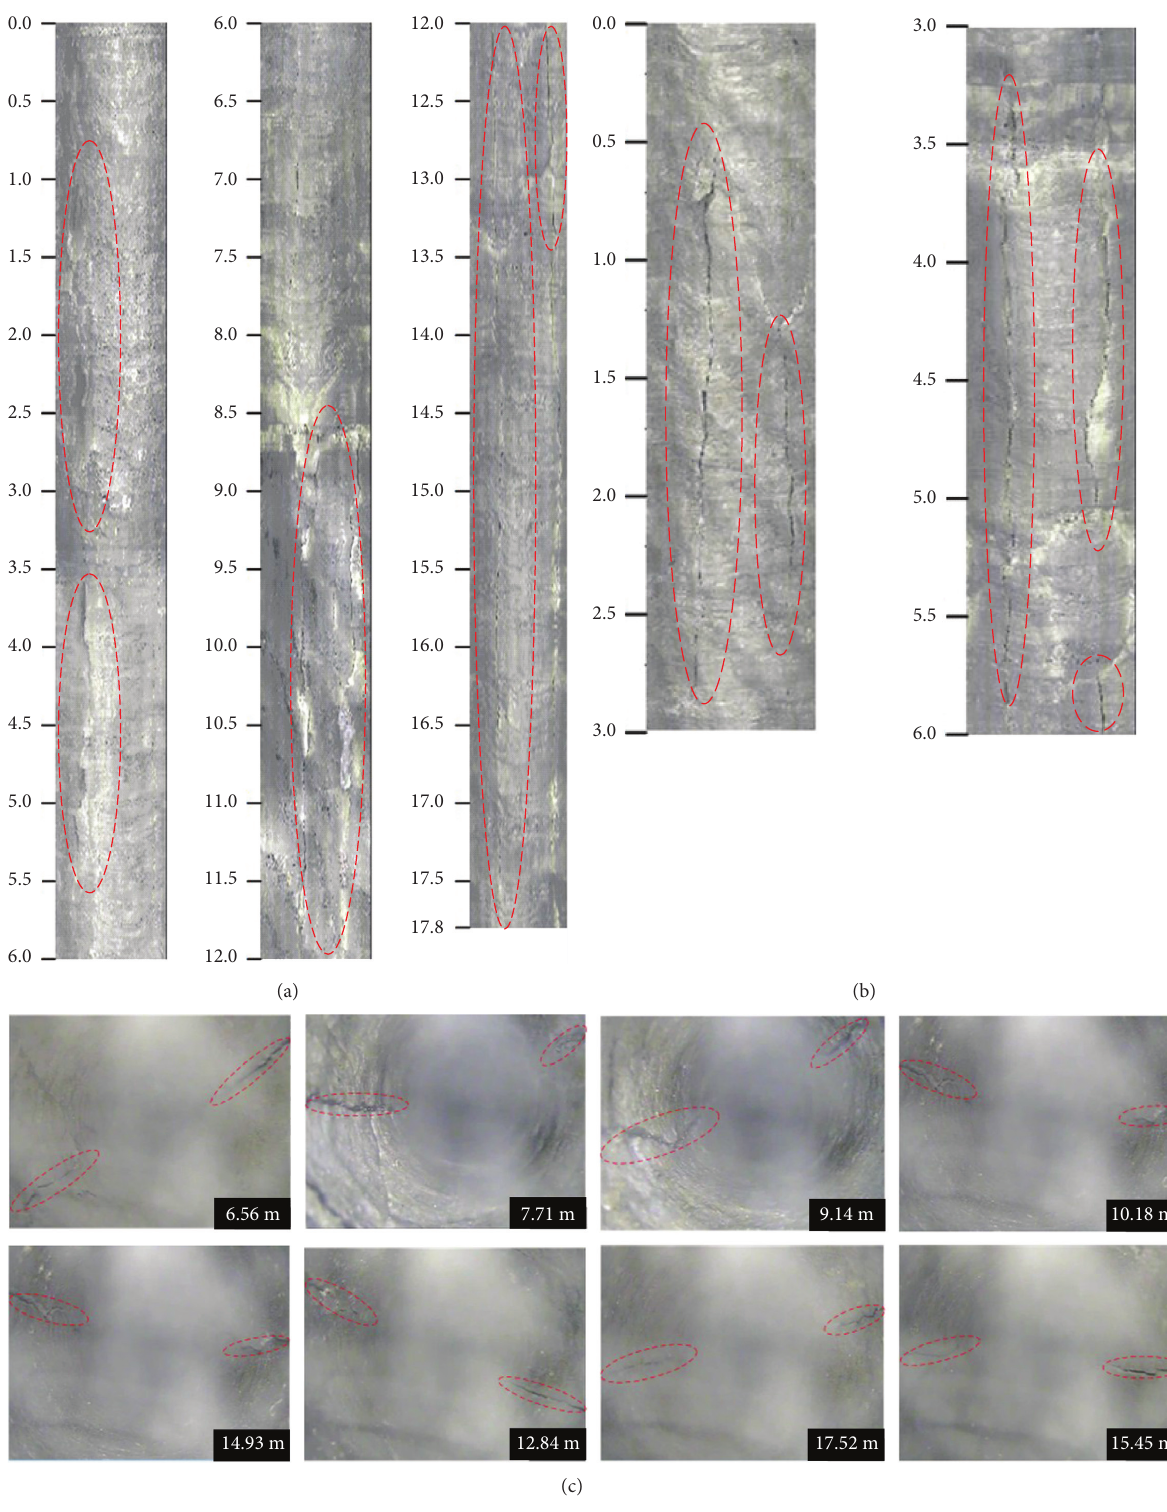
Figure 8: Test of roof cutting effect of presplitting blasting based on borehole peeping method. (a) Peeping results of typical deep hole presplitting blasting. (b) Peeping results of shallow hole blasting. (c) Symmetric fracture formation in a typical